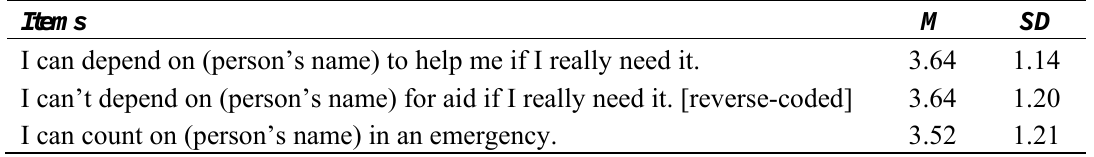
Table 1. Items, Means, and Standard Deviations for Perceived Access to Social Resources